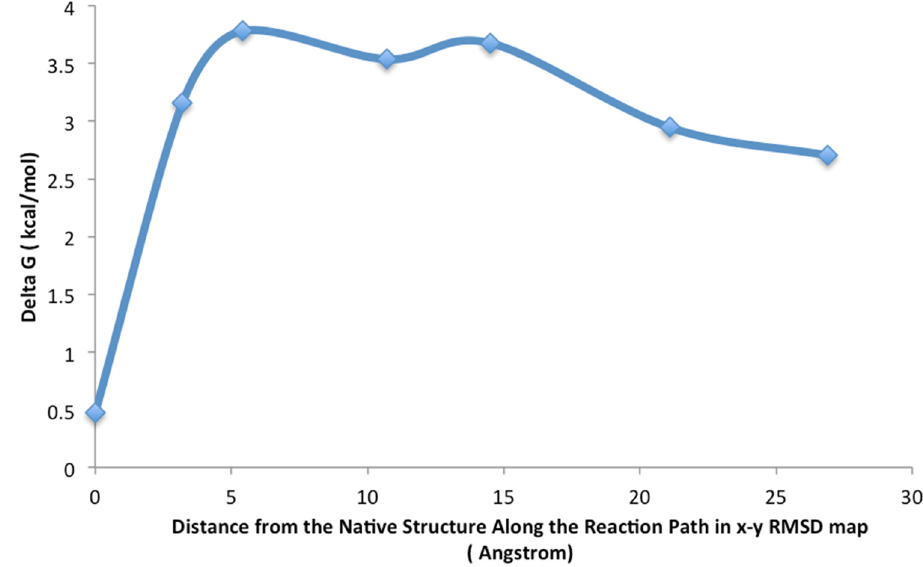
Figure 6. Calculated free energy profile for U1A unfolding with respect to the reaction coordinate indicated in Figure 4. The depth of the slight minimum after the activation barrier is ~0.2 kcal/mol and does not correspond to a thermally stable intermediate.